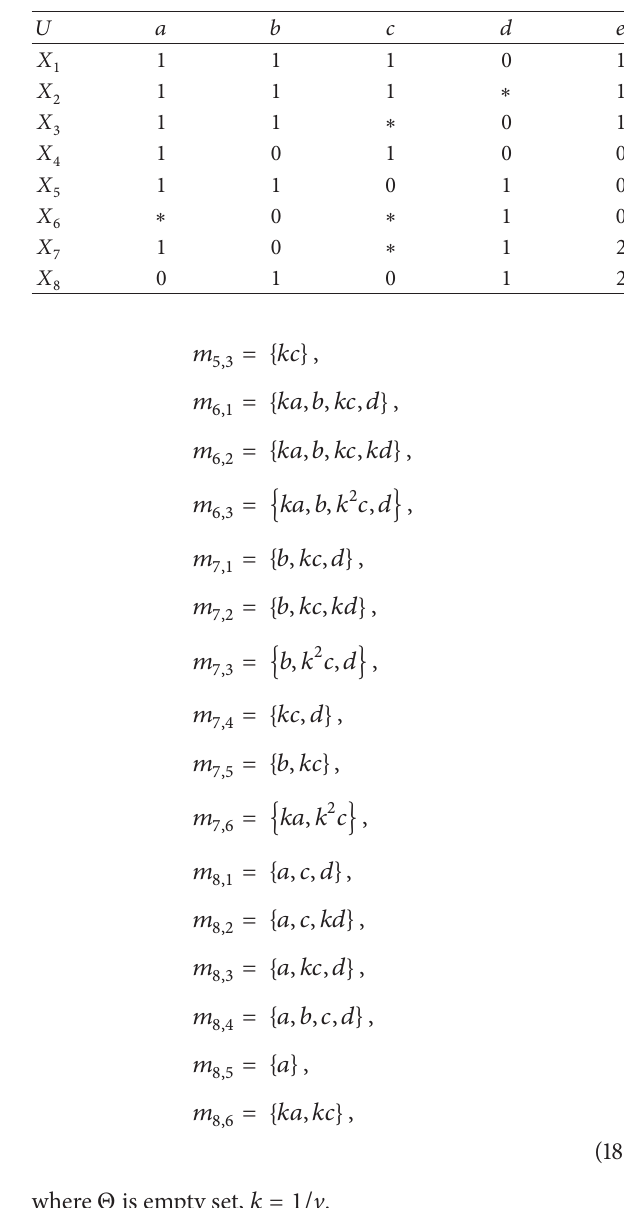
Table 1: Incomplete information